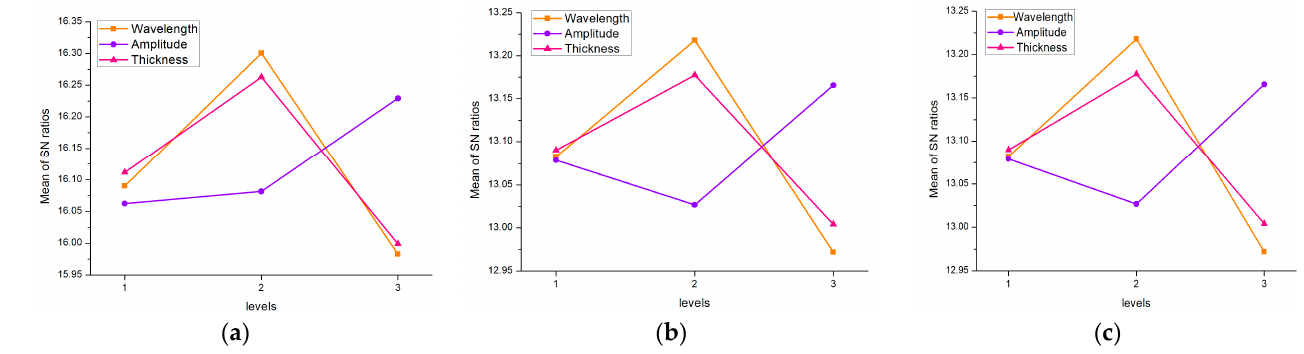
Figure 8. Mean SN ratio vs. levels for each factor . ( a ) Laayoune; ( b ) Essaouira; ( c )